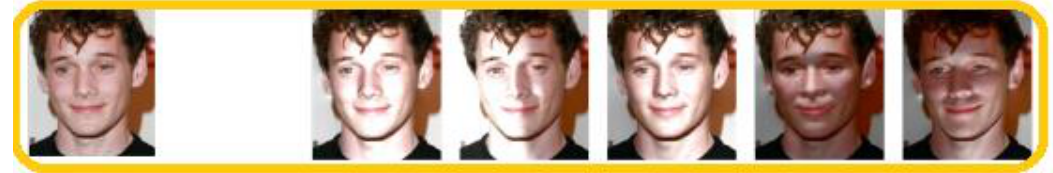
Figure 33. Lighting variation. The original image is on the left.